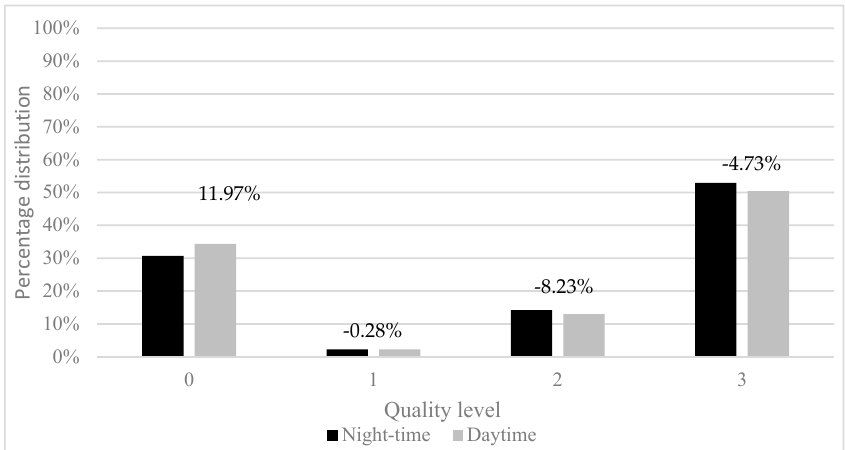
Figure 3. Number of overall reading qualities during daytime and night-time as well as their differences (day–night).